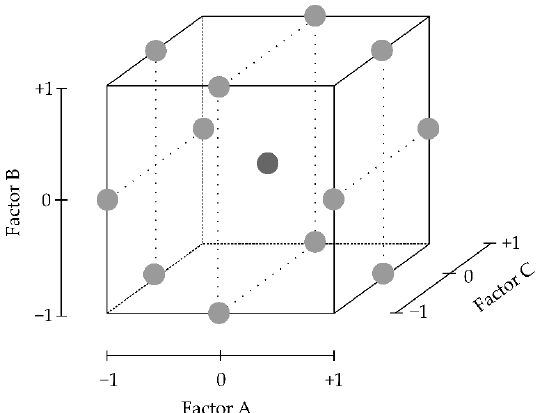
Figure 8. Graphical representation of the experimental runs for a three-factor Box–Behnken de-sign. Note that factor combinations happen at intermediate values (coded as “0”) for each factor, avoiding extreme value combinations.